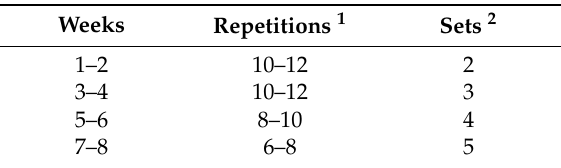
Table 1. Resistance training